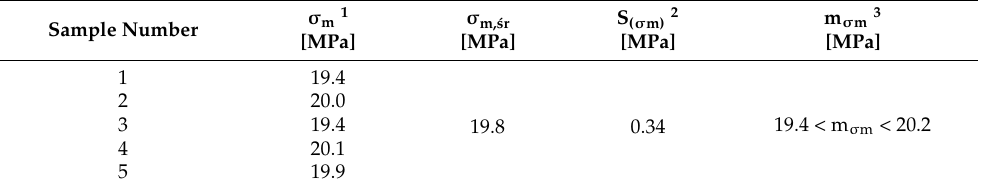
Table 5. Results of the determination of the maximum stress σ m for a population of 5 samples.